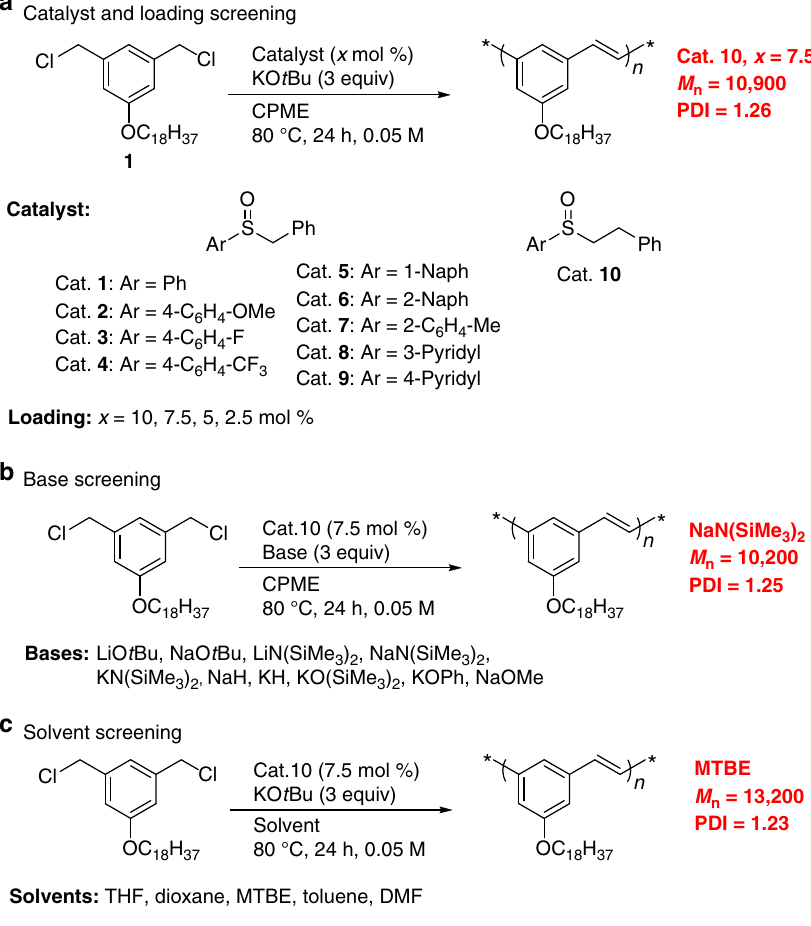
Fig. 2 Optimization by HTE Screening. a Precatalysts employed leading to sulfoxide 10 for further studies. b Additional base screen indicated that NaN (SiMe 3 ) 2 ( M n = 10,200) gave the best results, but lower than KO t Bu ( M n = 10,900) of panel a . c Additional solvent screen, wherein MTBE gave the best results ( M n = 13,200) higher than CPME of panel a . See Supplementary Table 3 for all